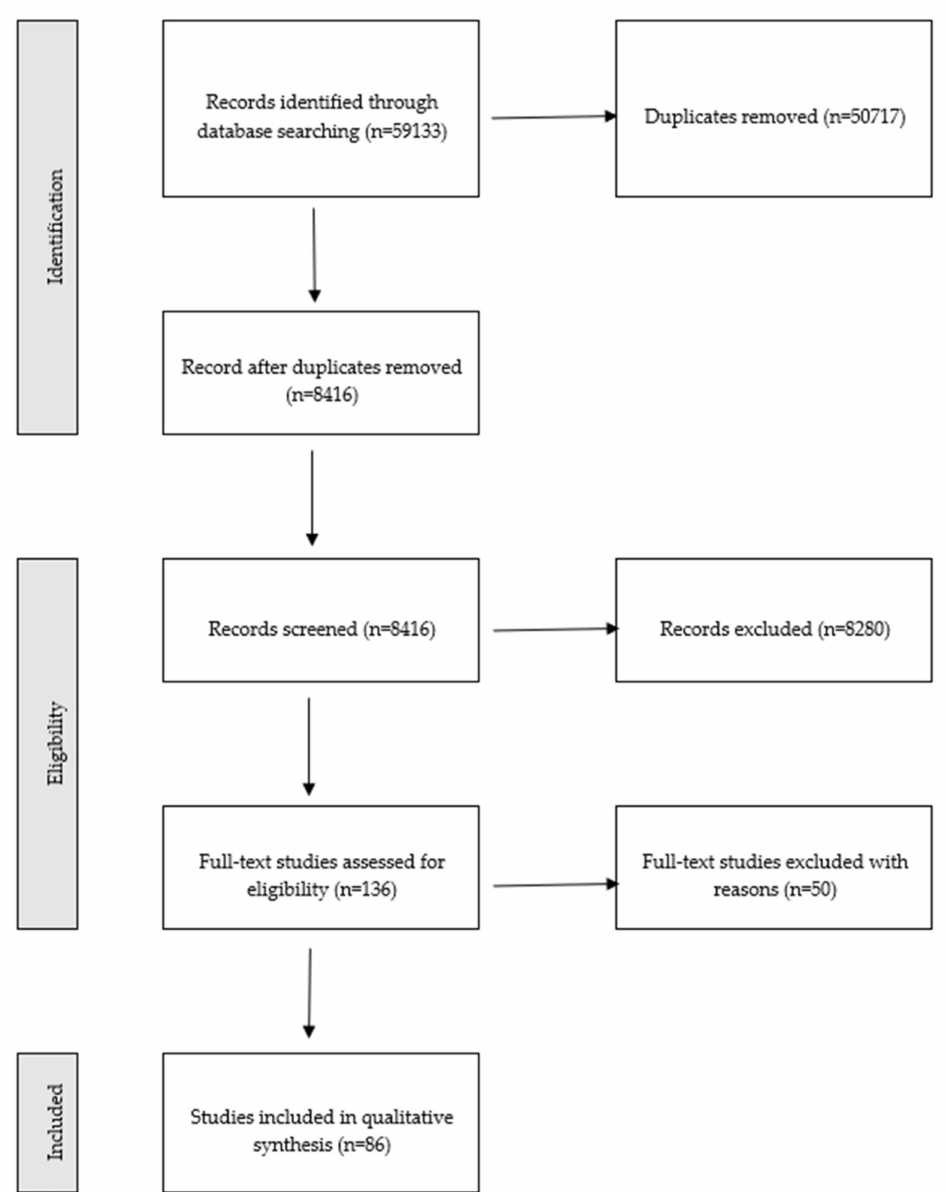
Figure 1. PRISMA flow